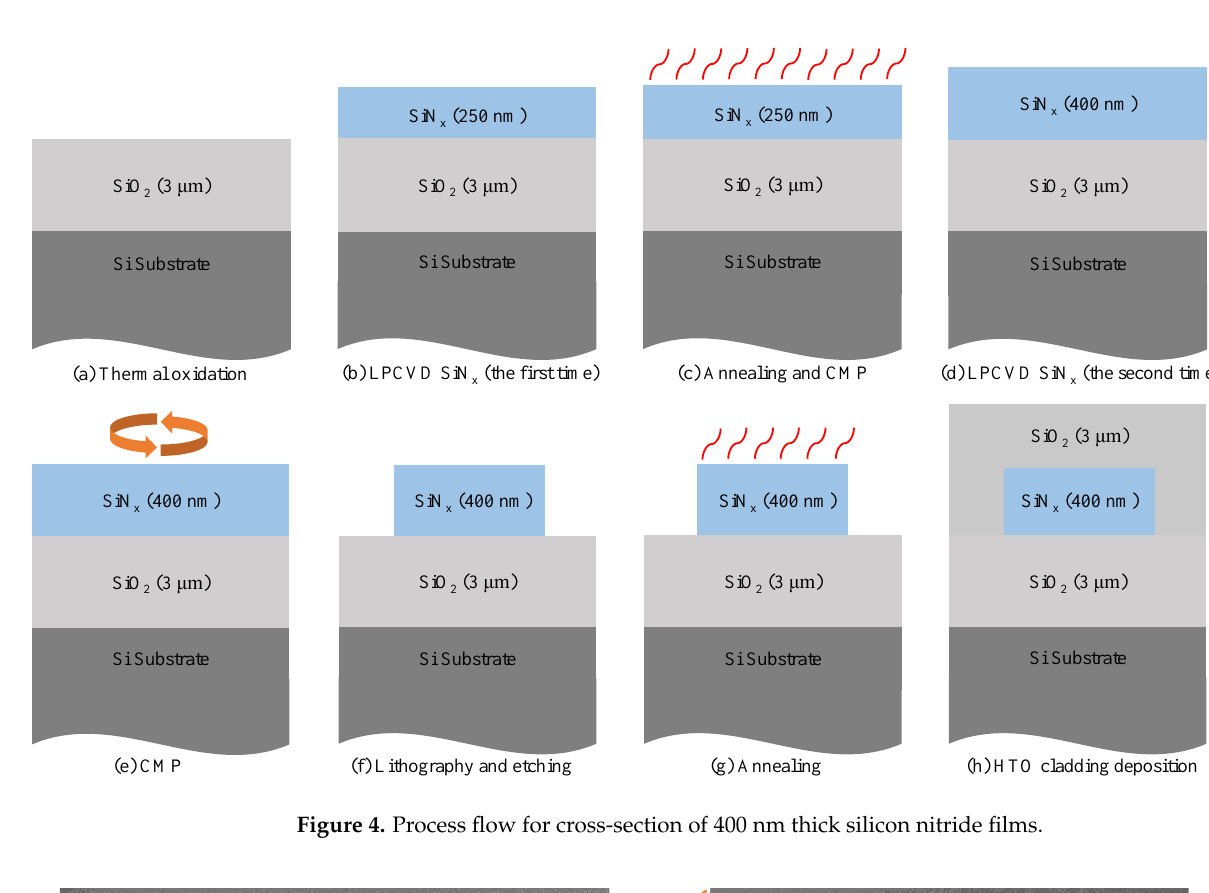
Figure 4. Process flow for cross-section of 400 nm thick silicon nitride films. The top-view scanning electron microscope (SEM) image of the bent DC is shown in Figure 5. The measured width of the bent waveguide was 1.01 μm (versus a designed width of 1 μm) , and the actual width of Gap was 294 nm (versus a designed width of 300 nm), satisfying the requirements for the devices.